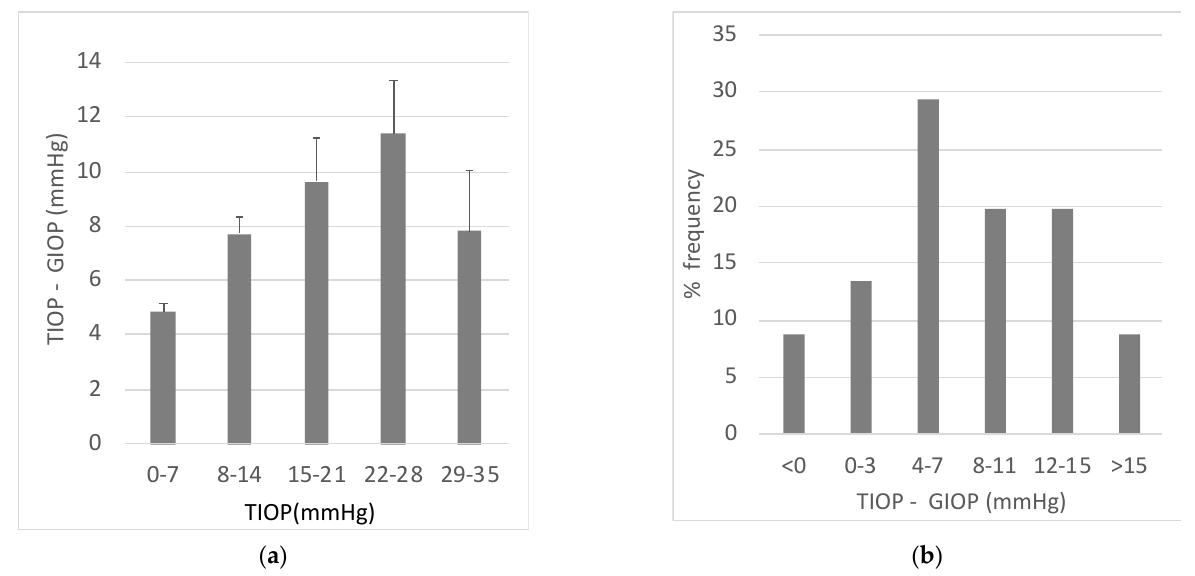
Figure 4. ( a ) Distribution of the difference between transducer intraocular pressure and Goldmann intraocular pressure (delta ‐ pressure, TIOP ‐ GIOP) for different intervals of transducer intraocular pressure, TIOP; ( b ) % frequency distribution of different intervals of delta ‐ pressure. Error bars in ( a ) are standard errors.